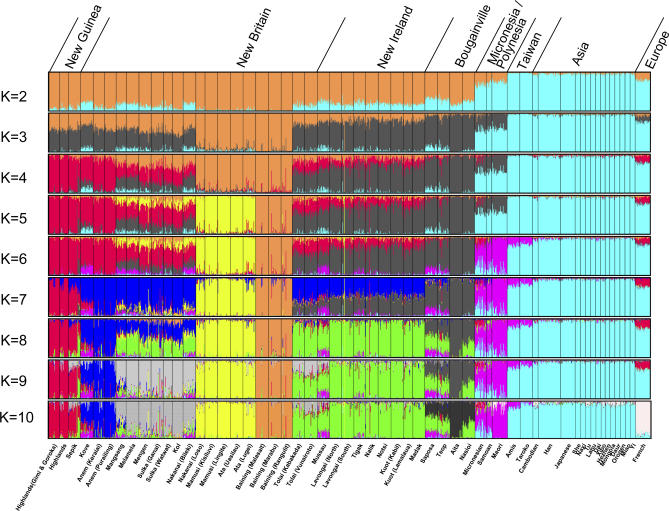
Pacific Population StructureSTRUCTURE analysis of the Pacific, HGDP-CEPH East Asia, and European (French) groups (687 microsatellites and 203 indels, 20,000/10,000 burnin/MCMC). Results are given from K = 2 to K = 10. Each vertical line represents an individual. The colors represent the proportion of inferred ancestry from K ancestral populations.